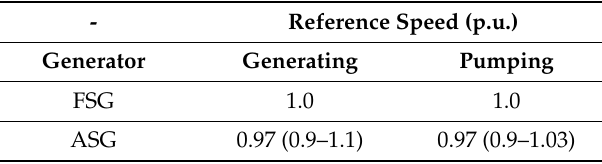
Table 3. Reference rotor speed of each